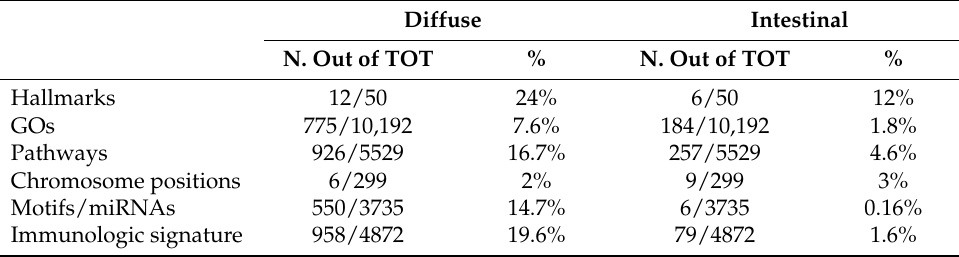
Table 2. Summary of the significantly enriched gene sets in Diffuse and Intestinal GC